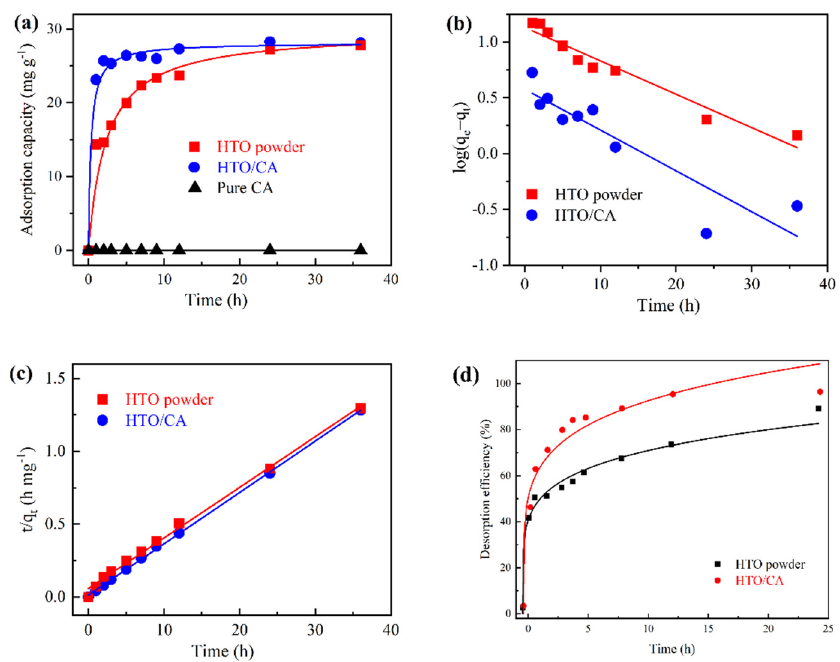
Figure 7. Li + adsorption/desorption behavior in adsorbents: ( a ) adsorption kinetics (pH = 10.25; V = 160 mL; m ≅ 100 mg; C 0 = [Li + ] ≅ 50 mg L − 1 ); ( b ) pseudo-first-order kinetics; ( c ) pseudo-second-order kinetics; and ( d ) desorption efficiency over time (V = 160 mL, C 0 = 0.2 M HCl).